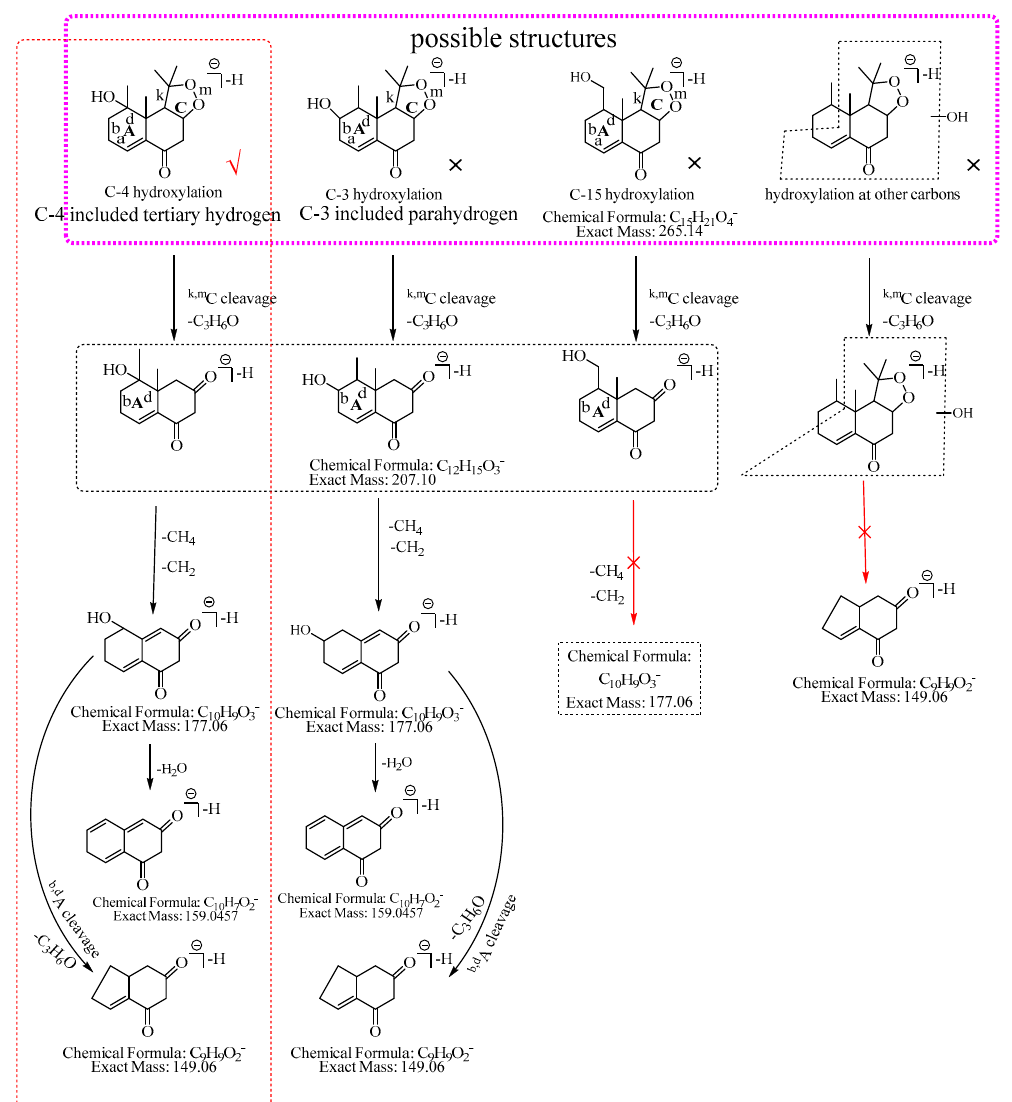
Figure 3. The proposed fragmentation pathways of M1 (4-hydroxyl nardosinone). “ √ ” represents the possible structure. “×” represents the impossible structure. The purple rim represents the possible structures; A and C represent the hexatomic rings, respectively. The red rim represents the most possible fragmentation pathway.